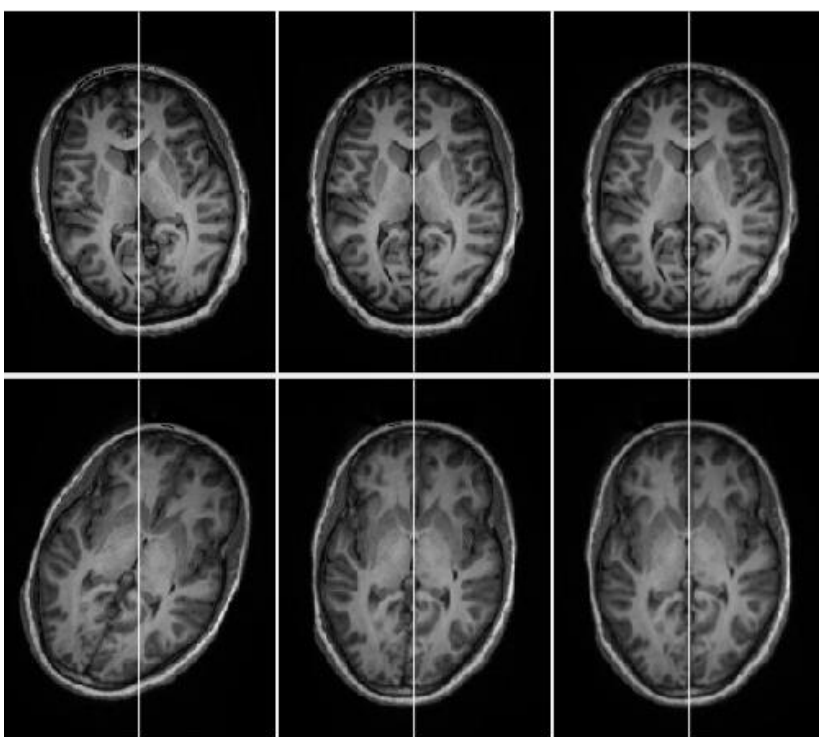
Figure 5. Estimation of symmetry axis orientation θ r . First column: input images; second column: alignment of the brain bilateral symmetry axis with the vertical axis of the image using θ 1 ; last column: brain bilateral symmetry axis alignment using θ r = θ 1 + θ 2 . Note that θ 2 = 0 in the first row.